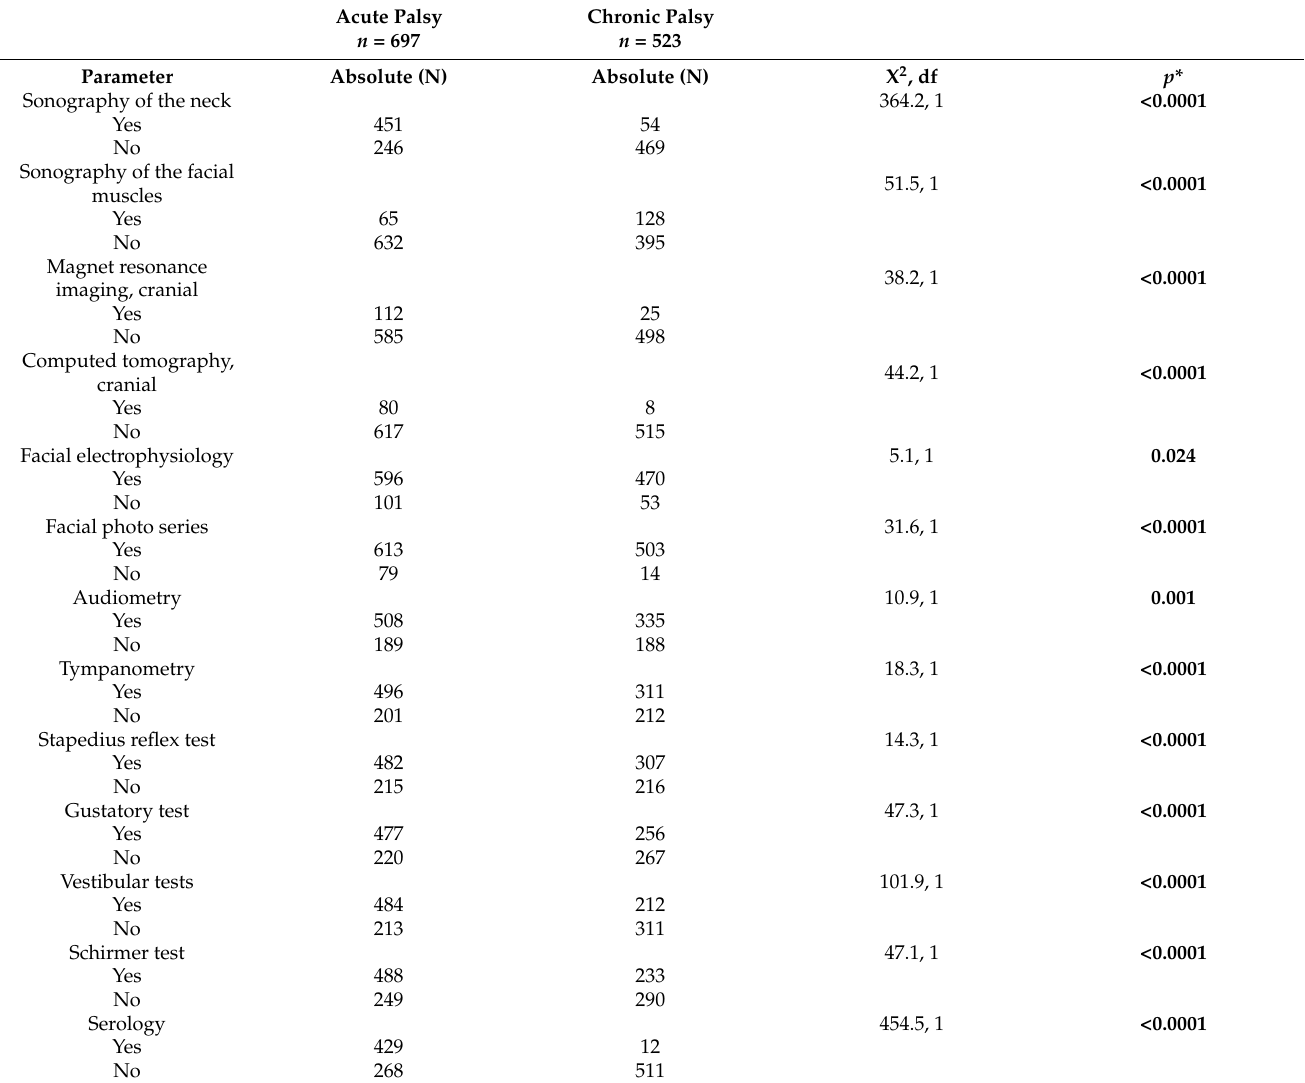
Table 2. Comparison of necessary diagnostics in the case of acute facial palsy ( ≤ 90 days after onset) versus chronic facial palsy (>90 days after